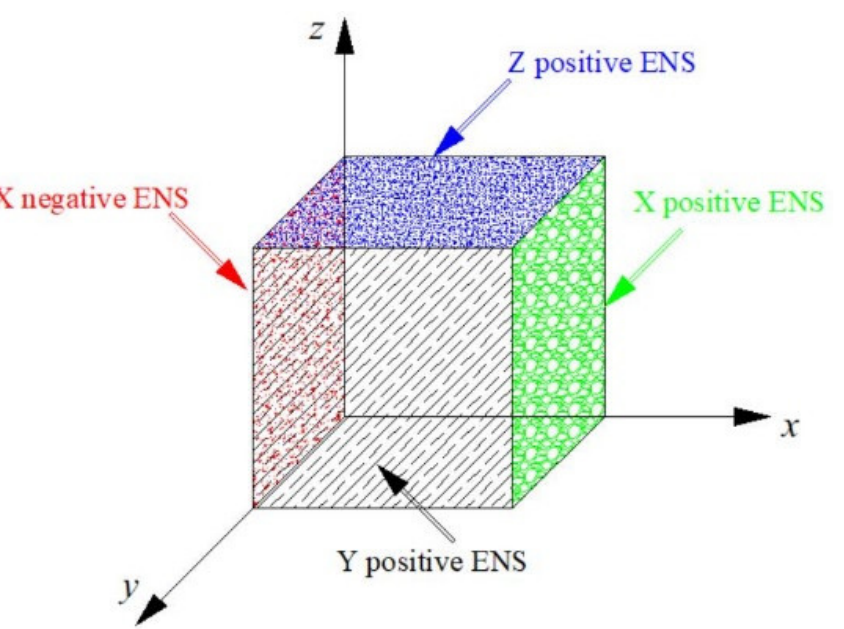
Figure 6. schematic diagram of model entrance surface. Figure 6. Schematic diagram of model entrance